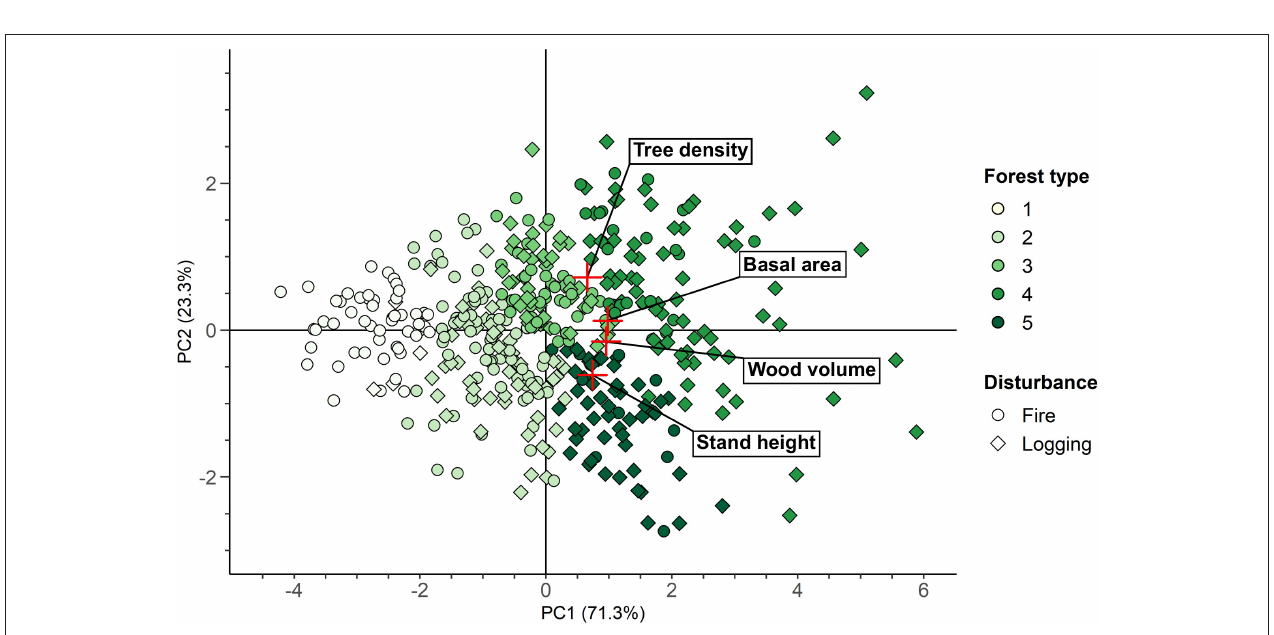
FIGURE 3 | (A) Mean decrease accuracy (MDA) and (B) mean decrease Gini (MDG) values of the transect attributes considered in the random forest analysis, comparing burned, and logged transects. Red dots indicate transect attributes that presented significant differences based on the disturbance type on the nested PERMANOVA test, white dots non-significant results and gray dots indicate transect attributes that were not analyzed with the nested PERMANOVA test. Prop., proportion.